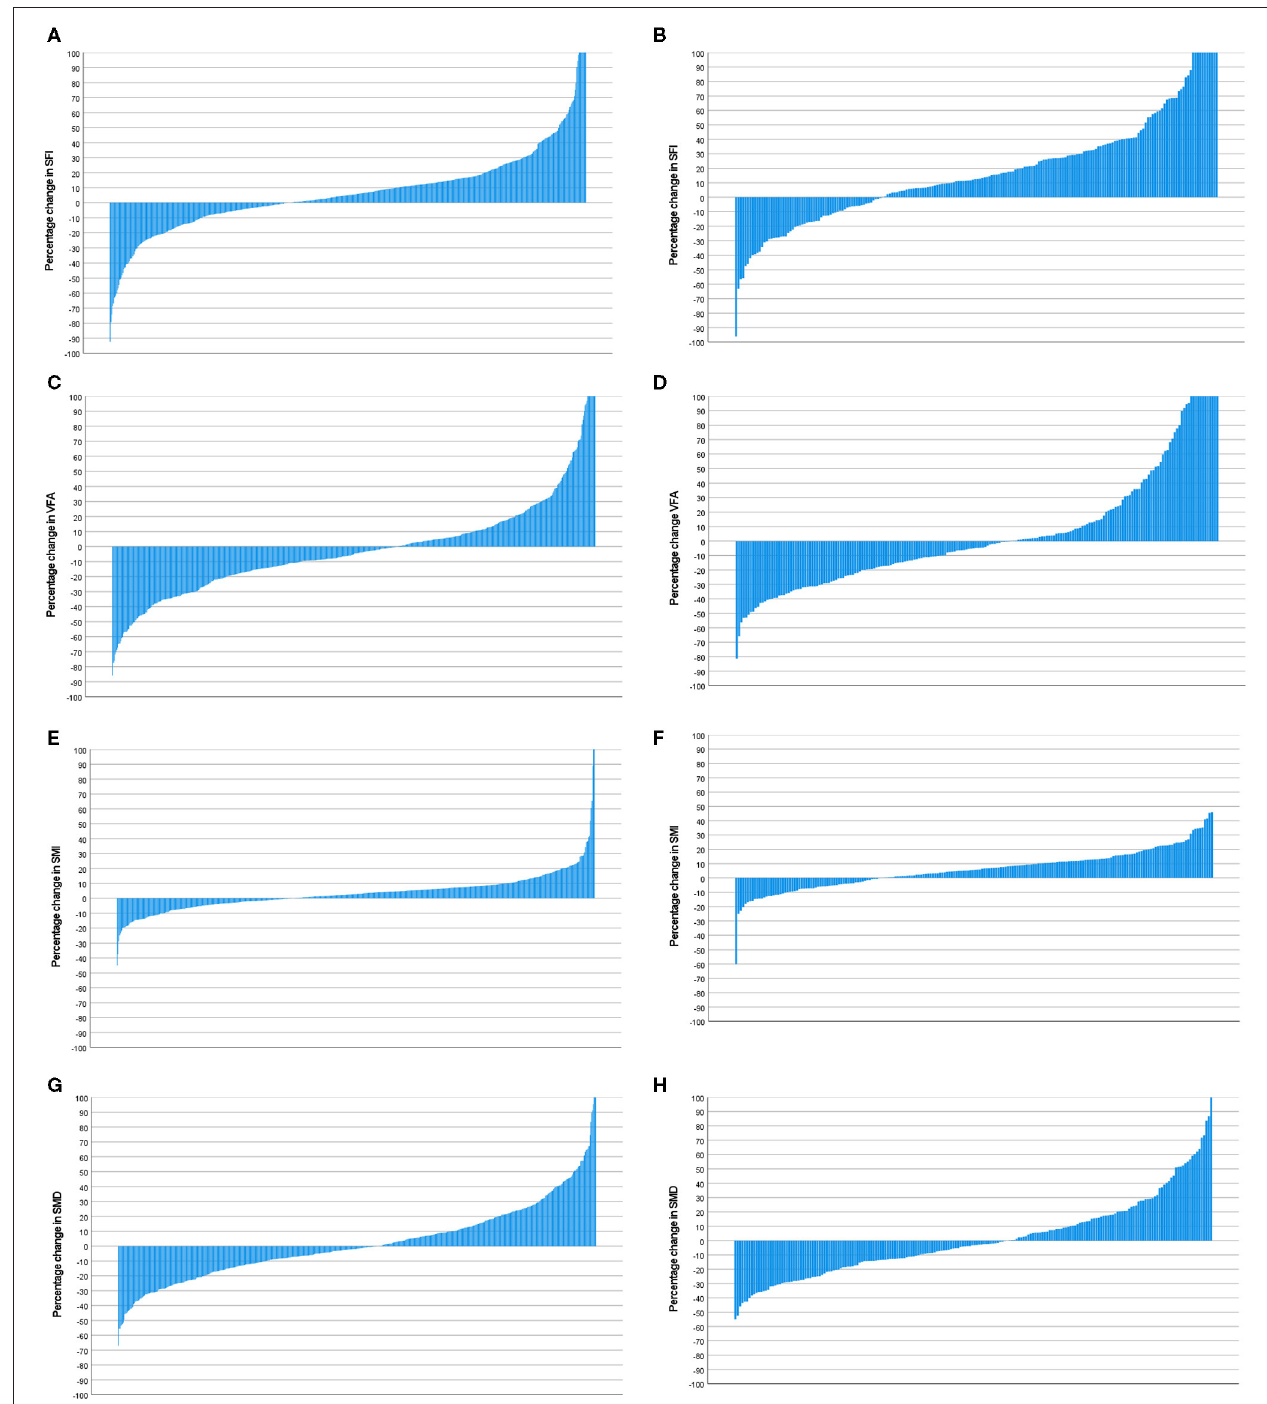
FIGURE 7 | (A) Percentage change in SFI in patients with a mGPS 0 ( n = 600). (B) Percentage change in SFI in patients with a mGPS 1 or 2 ( n = 204). Comparison of percentage change in SFI in mGPS 0 ( n = 600) and mGPS 1 or 2 ( n = 204) patients ( p < 0.001). (C) Percentage change in VFA in patients with a mGPS 0 ( n = 600). (D) Percentage change in VFA in patients with a mGPS 1 or 2 ( n = 204). Comparison of percentage change in VFA in mGPS 0 ( n = 600) and mGPS 1 or 2 ( n = 204) patients ( p = 0.614). (E) Percentage change in SMI in patients with a mGPS 0 ( n = 600). (F) Percentage change in SMI in patients with a mGPS 1 or 2 ( n = 204). Comparison of percentage change in SMI in mGPS 0 ( n = 600) and mGPS 1 or 2 ( n = 204) patients ( p = 0.002). (G) Percentage change in SMD in patients with a mGPS 0 ( n = 600). (H) Percentage change in SMD in patients with a mGPS 1 or 2 ( n = 204). Comparison of percentage change in SMD in mGPS 0 ( n = 600) and mGPS 1 or 2 ( n = 204) patients ( p =